Question: Identify the chart type used in this figure.
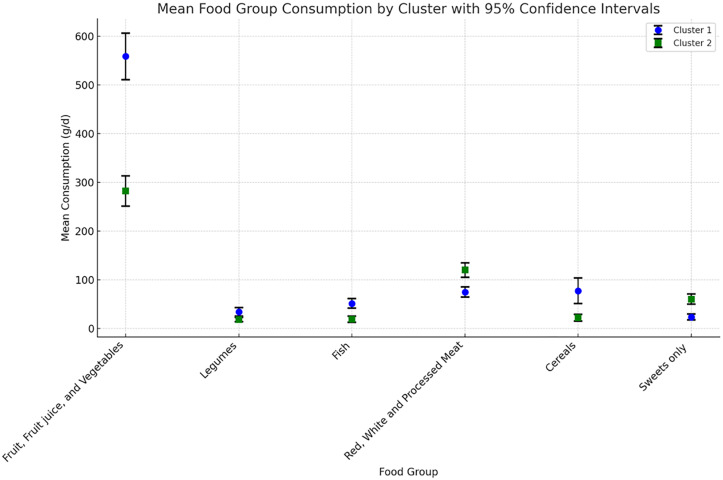
Answer: bar